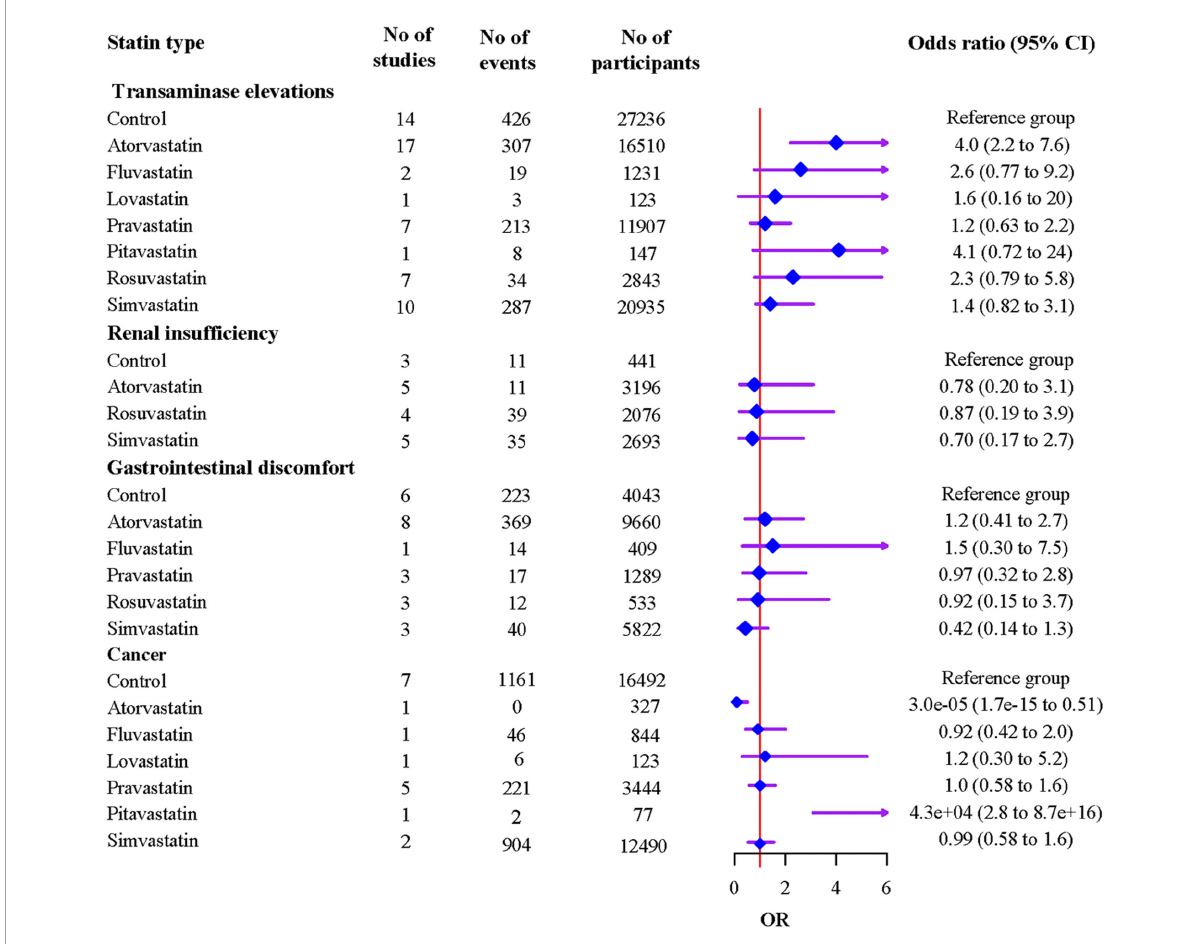
FIGURE4 Associations of individual statins with adverse events from network meta-analyses.